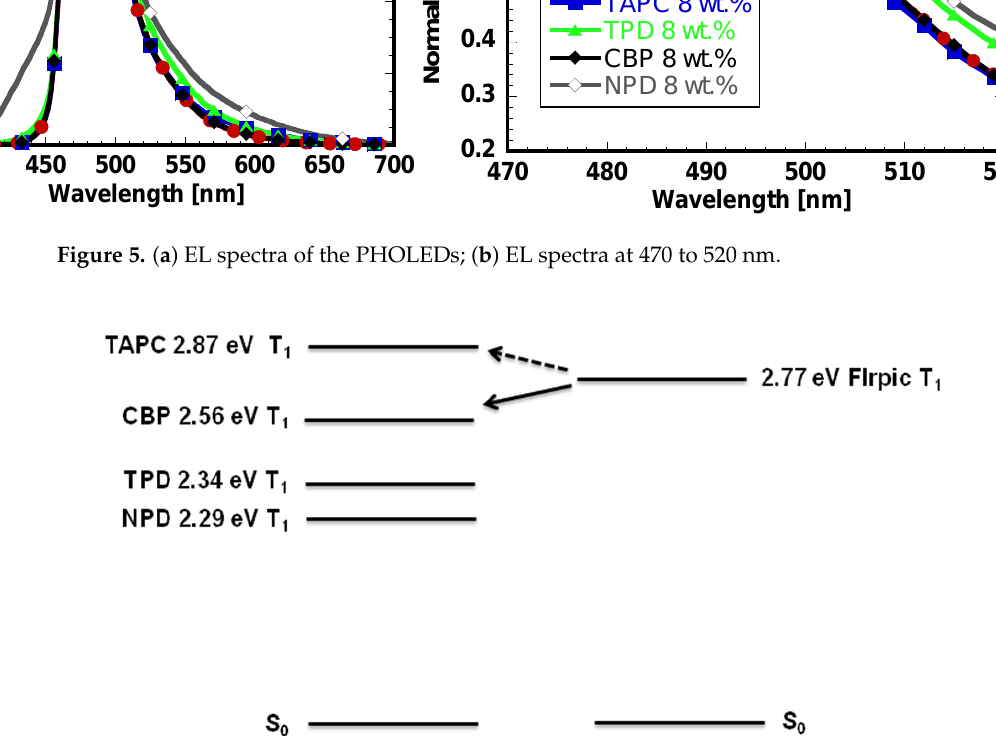
Figure 6. Comparison of the triplet energy values .